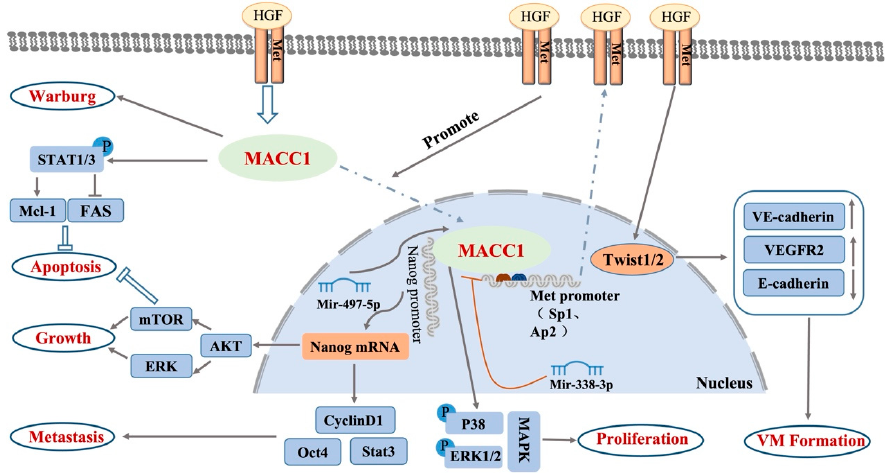
Figure 2. MACC1 effectors, signaling mechanisms, and biological responses. MACC1 is involved in a variety of cancer hallmark functions such as proliferation, metastasis, apoptosis resistance, angiogenesis and Warburg through transcriptional activation of its key target molecules HGF/c-Met, Akt, TWIST1/2, MAPK, Nanog/Oct-4, and